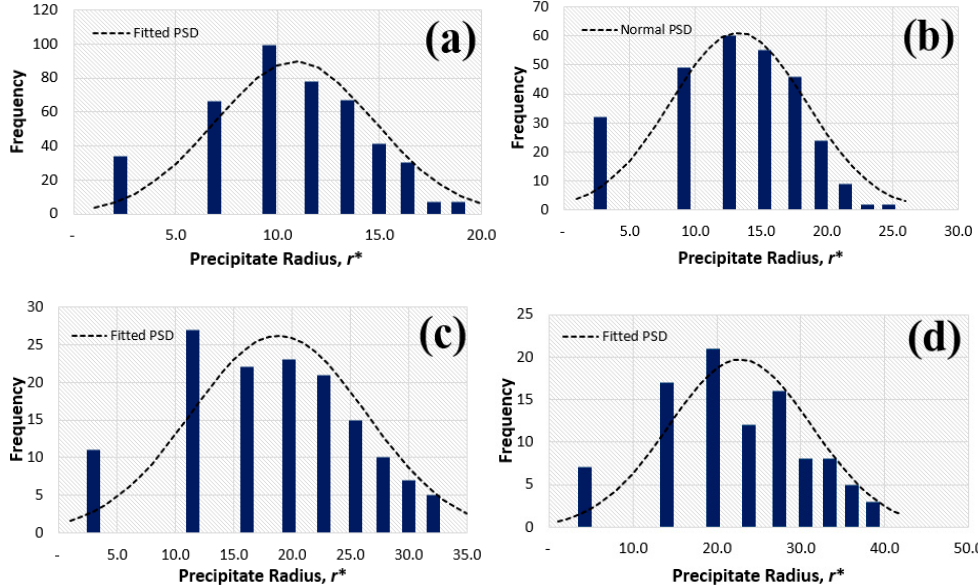
Figure 7. Histograms of the PSD in presence of 10% nanoparticles of size 10 at different times t * of: